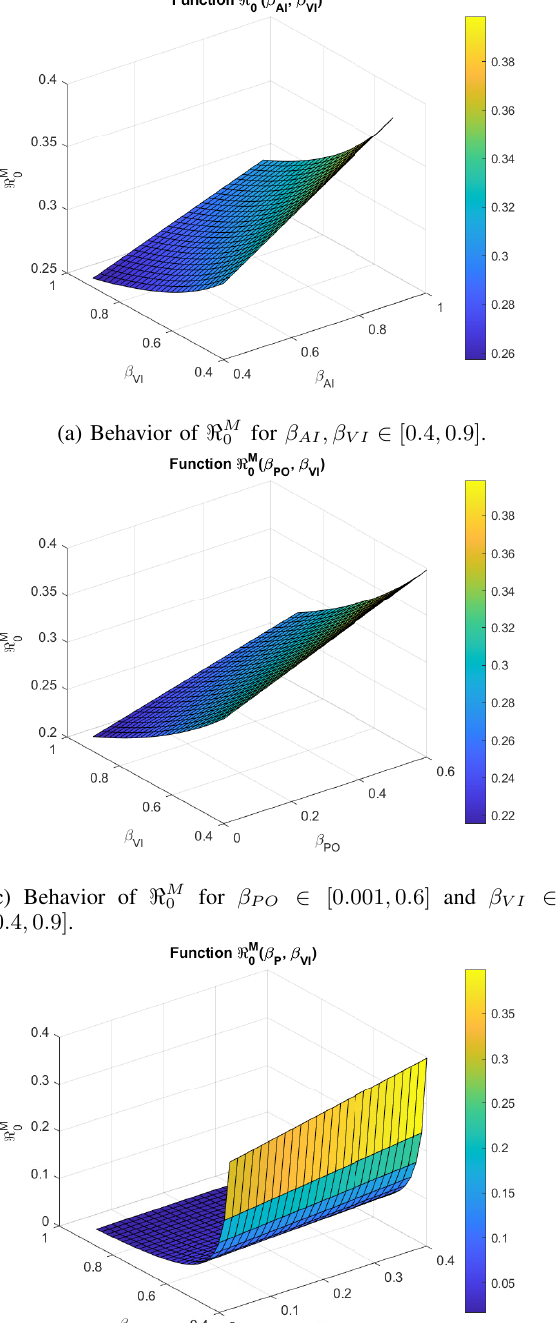
(b) Contour lines (cid:60) M 0 ( β AI , β V I ) .